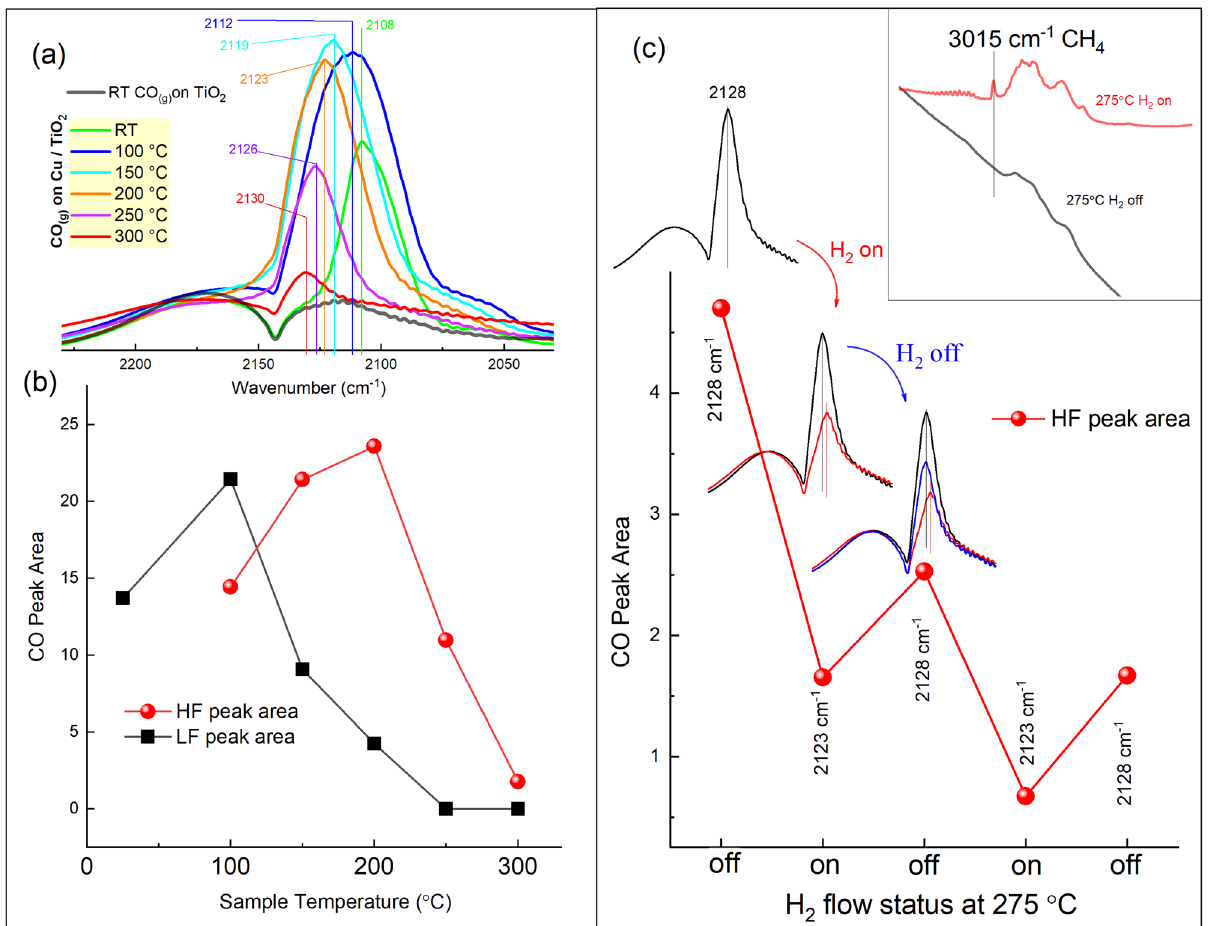
Fig. 5 DRIFTS spectra for high-temperature CO and CO-H 2 adsorption. a CO adsorption peaks under continuous CO fl ow over Cu/TiO 2 and as the temperature increases. The spectra were collected 10 min. after reaching the desired temperature. b Peak areas for the HF and LF CO peaks that were deconvoluted from a . c CO adsorption peaks at 275 °C under continuous CO fl ow over Cu/TiO 2 , and as the fl ow was switched back and forth between Ar + CO and H 2 + CO.